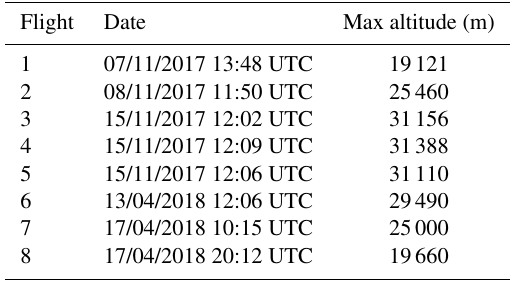
Table 2. List of flights between November 2017 and April